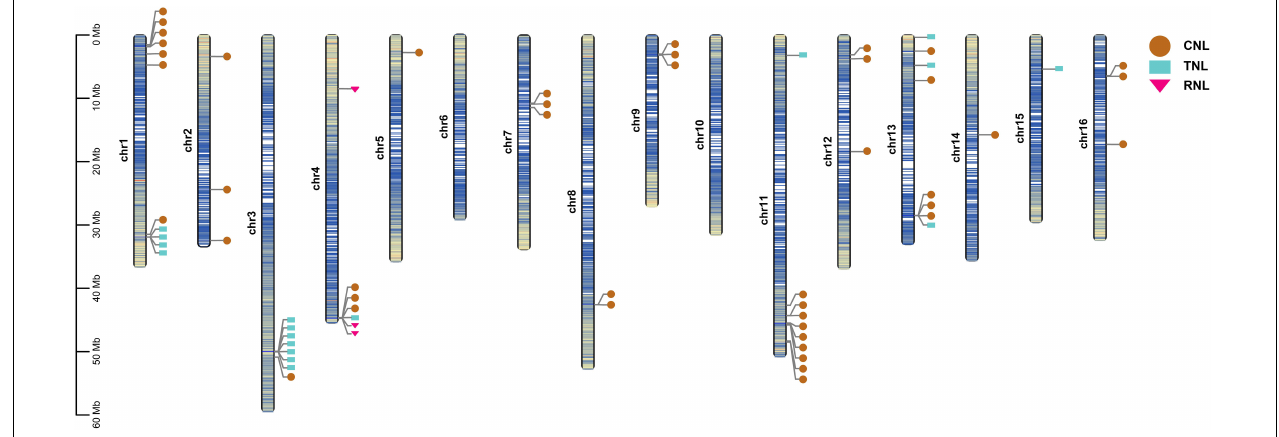
FIGURE 2 | Chromosomal distribution of NBS genes in A. trifoliata . The relative mapping positions of 64 identified NBS genes are shown on the chromosomes. CNL genes are represented by brown circles, while TNL and RNL genes are represented by blue rectangles and pink triangles, respectively. The shade of the chromosome color represents gene density, where the bluer the color, the higher the density, and the yellower the color, the lower the